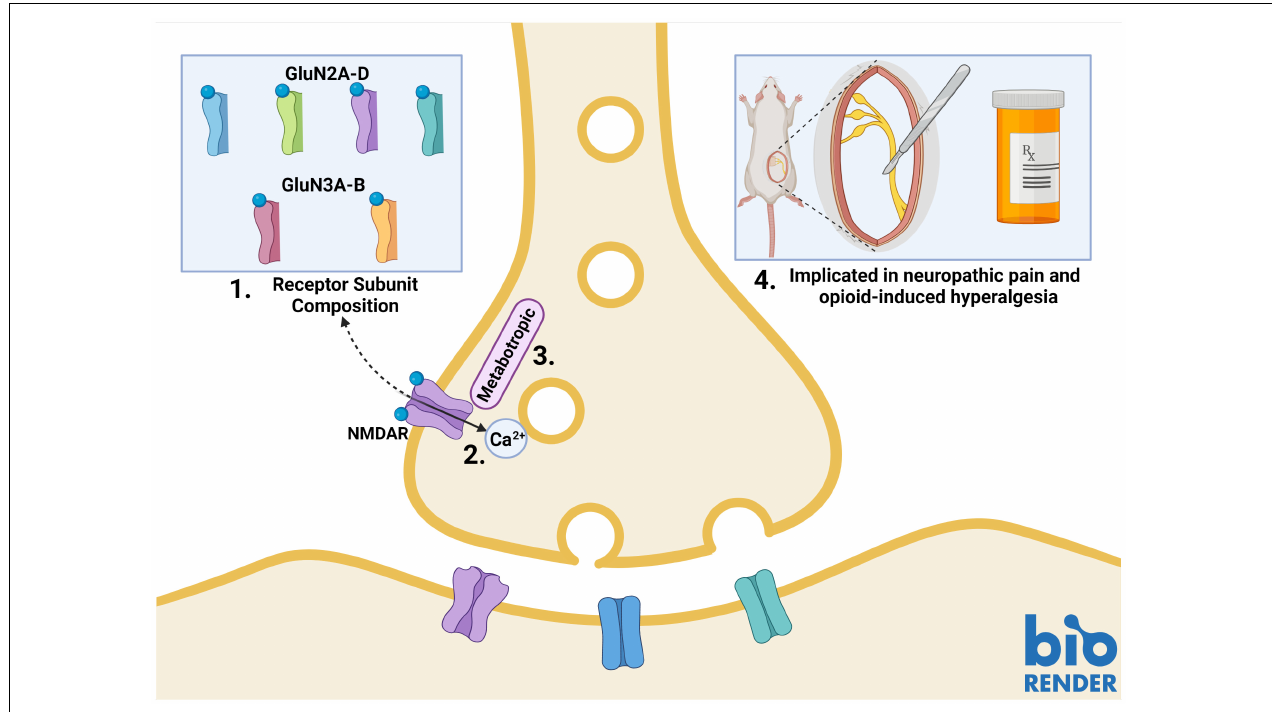
FIGURE 1 | Properties of presynaptic N -methyl- D -aspartate receptors (preNMDARs) in the superficial dorsal horn (SDH). 1. GluN2A and GluN2B-containing preNMDARs in primary afferents have been implicated in pain models. Low Mg 2 + sensitivity suggests a potential role of GluN2D or GluN3-containing preNMDARs. 2. PreNMDARs may contribute to signaling in the SDH by either direct cation influx, or 3. By metabotropic signaling. 4. To date, preNMDARs have been found to contribute to both neuropathic pain and opioid-induced hyperalgesia, but not to non-pathological nociception. Figure was created using BioRender.com.